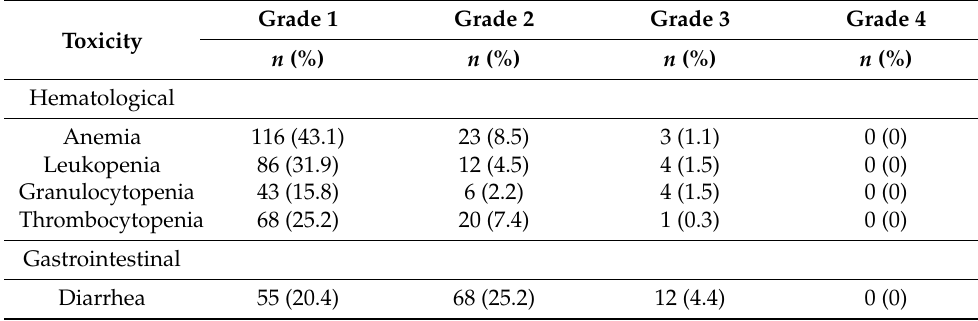
Table 2. All grade toxicity during